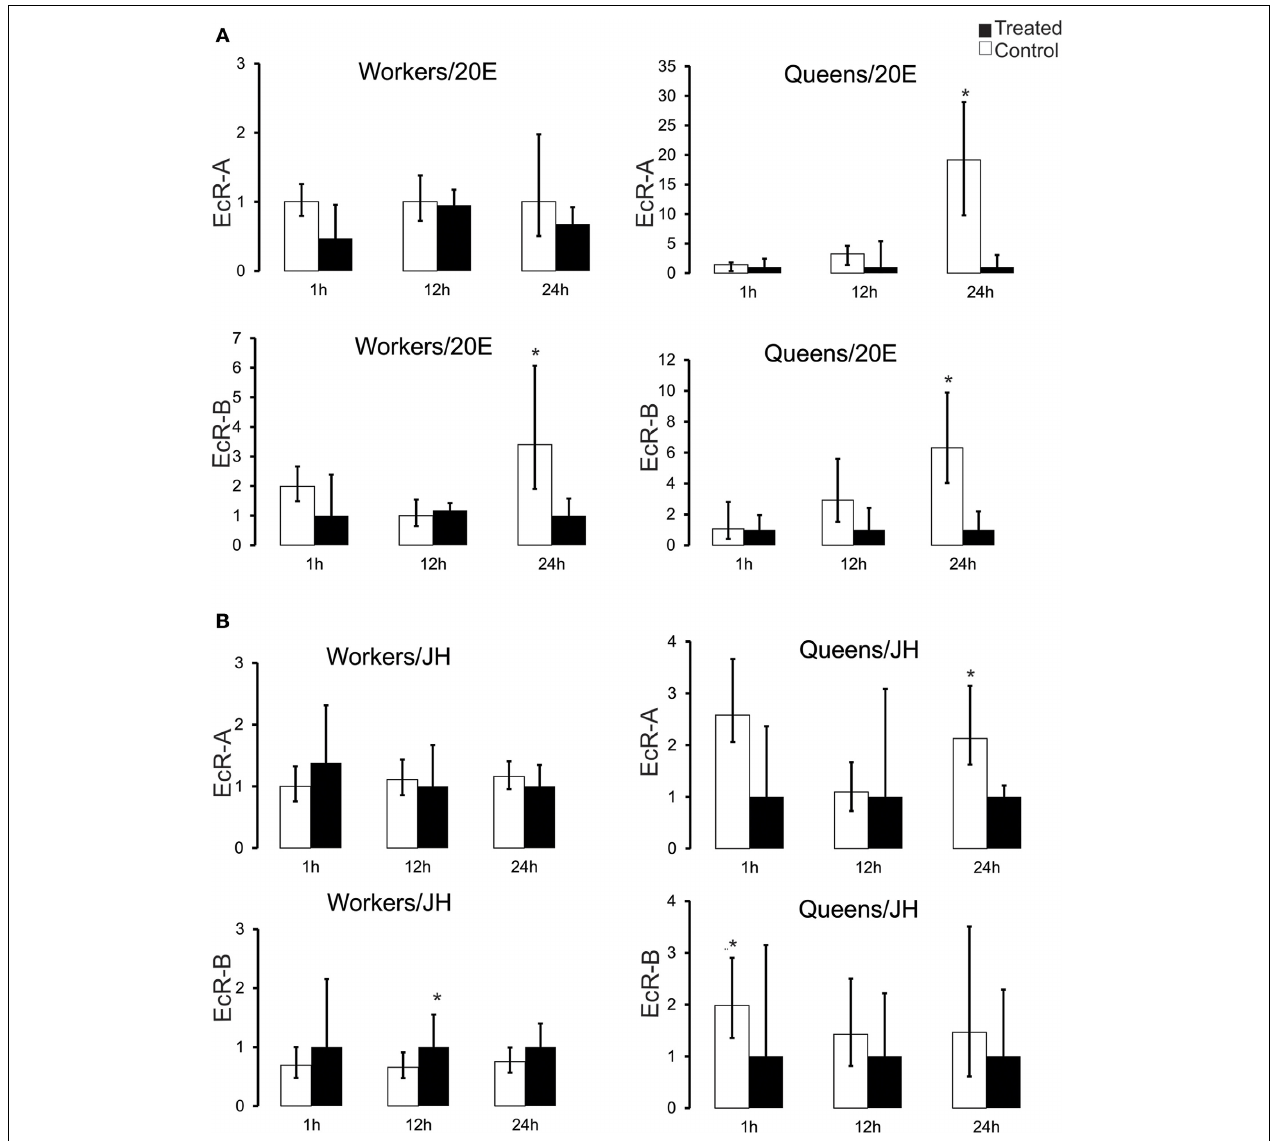
FIGURE 3 | EcR expression response to experimentally augmented levels of (A) 20-hydroxyedysone (20E) and (B) juvenile hormone (JH) in honeybee castes. Aliquots of 5 μ g of 20E or 10 μ g of JH-III were applied to brown-eyed pharate-adults with unpigmented cuticle (Pb phase). RNA samples from fat bodies were obtained after 1, 12, and 24h after hormone